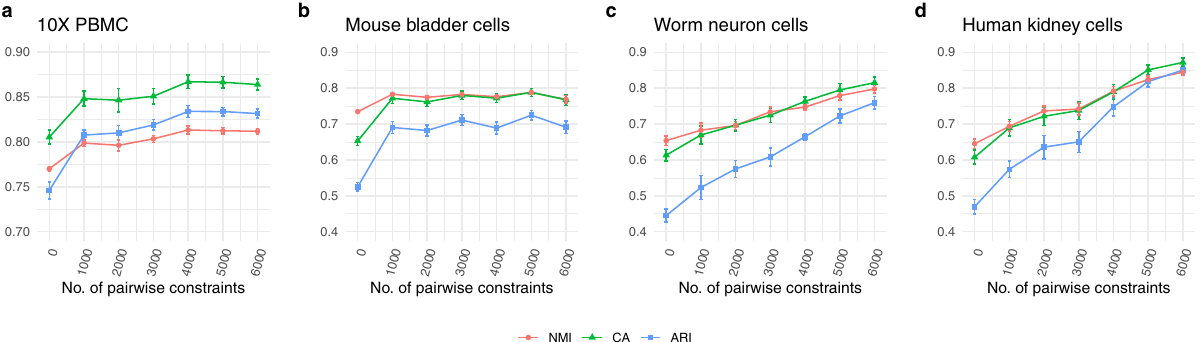
Fig. 2 Performances of scDCC on small datasets. a 10X PBMC; b Mouse bladder cells; c Worm neuron cells; d Human kidney cells. Clustering performances of scDCC on four small scRNA-seq datasets with different numbers of pairwise constraints, measured by NMI, CA, and ARI. All experiments are repeated ten times, and the means and standard errors are